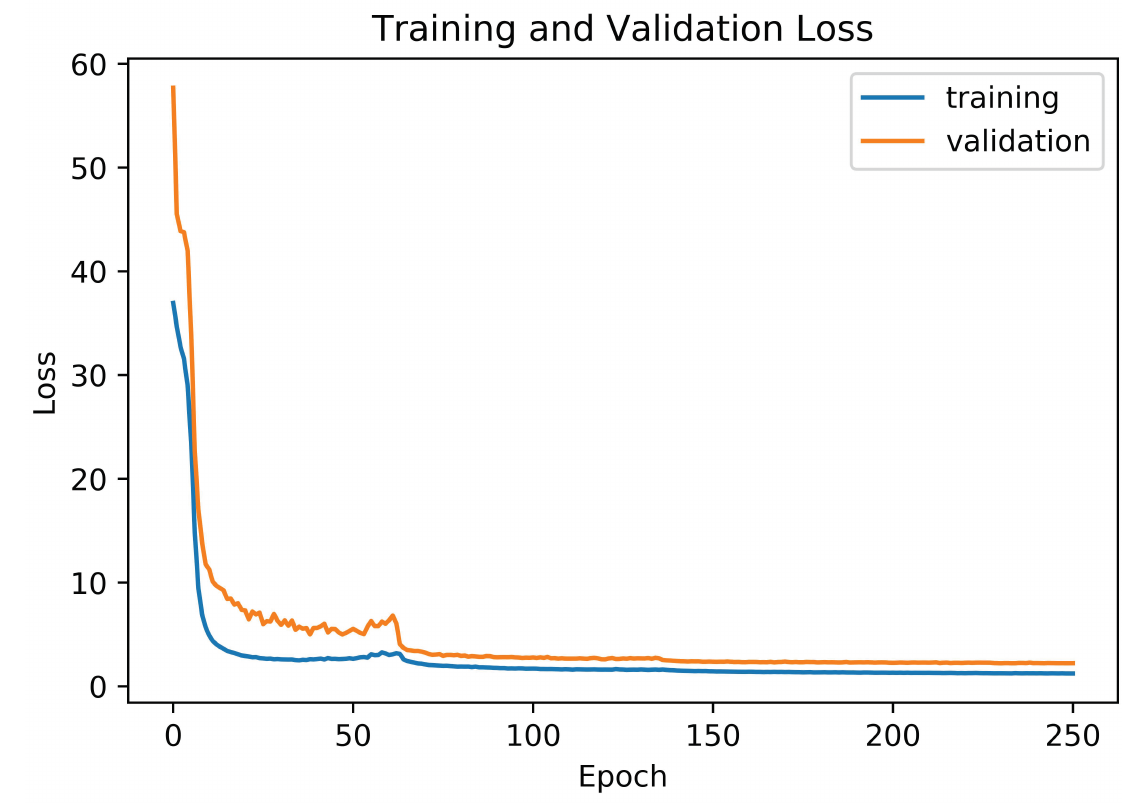
Figure 5. Training and validation loss.